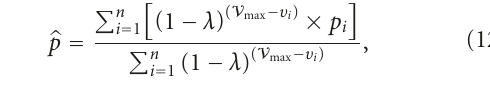
Algorithm 4.3 (RWL algorithm). The relative span weighted